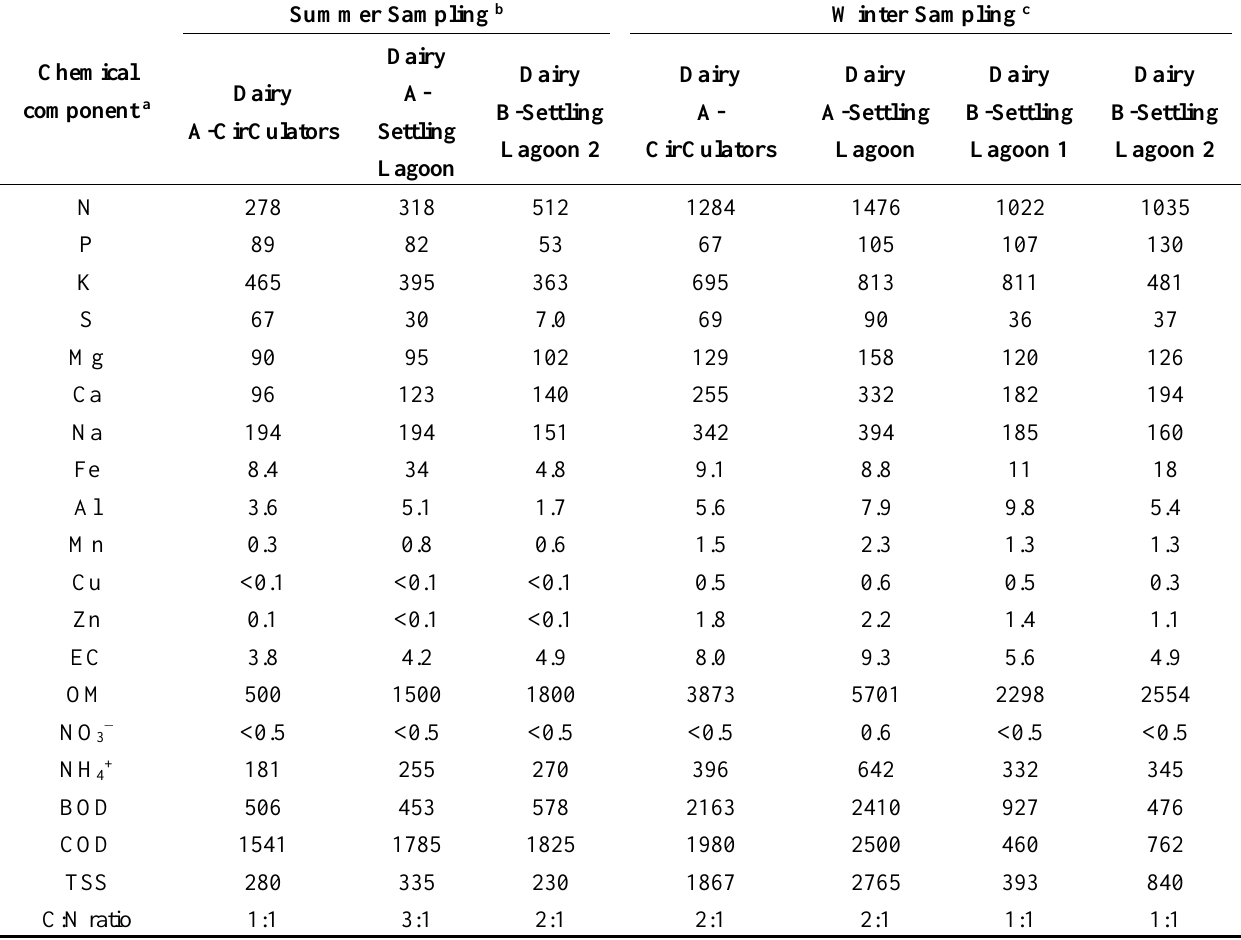
Table 1. Chemical characteristics of wastewater from two